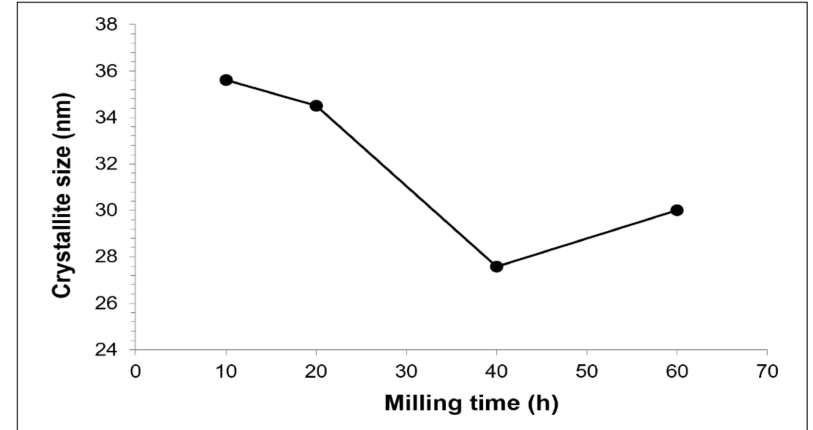
Figure 8. Cu crystallite size in Cu-W-C sintered composite at various milling times.